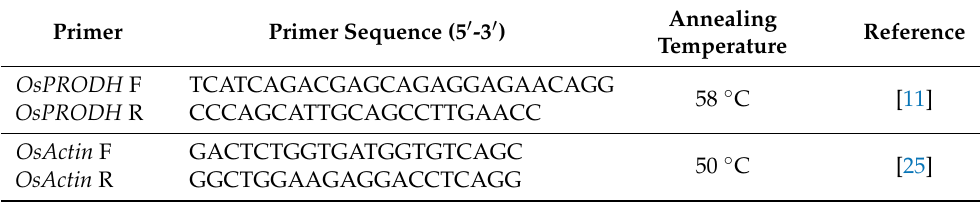
Annealing Reference Temperature 58 ◦ C [11] 50 ◦